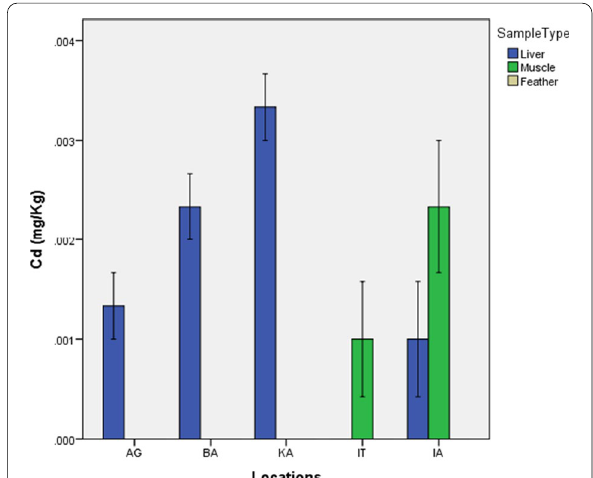
Fig. 2 Level of cadmium (Cd) in sampling locations (mg/kg)